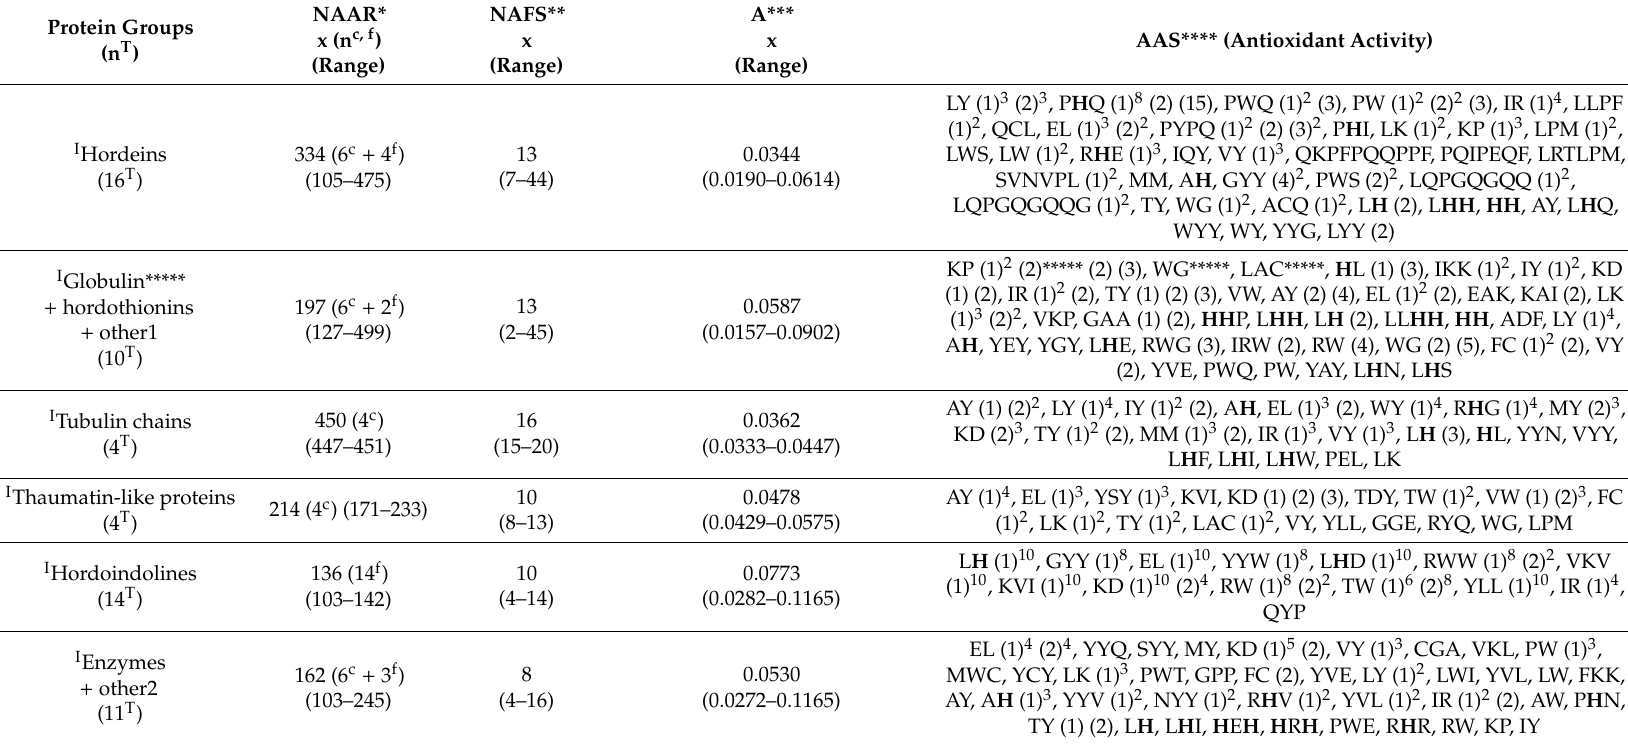
Table 3. Characteristics of barley proteins antioxidant activity ( I Hordeum